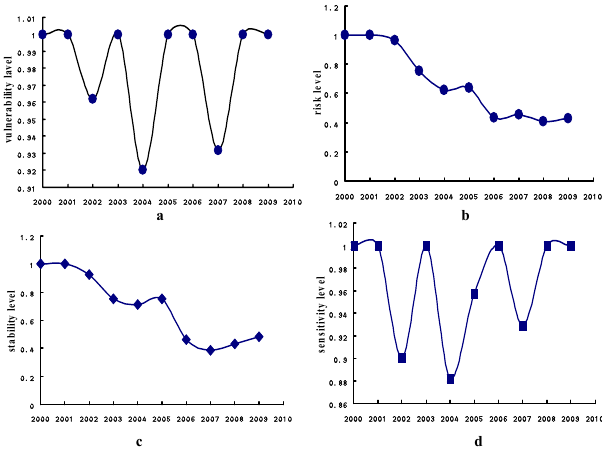
Fig.10. The flood system vulnerability trend(a), risk (b), the stability (c) and sensitivity ( d) in 2000-2009 Fig. 10. The flood system vulnerability trend (a) , risk (b) , the sta- bility (c) and sensitivity (d) in